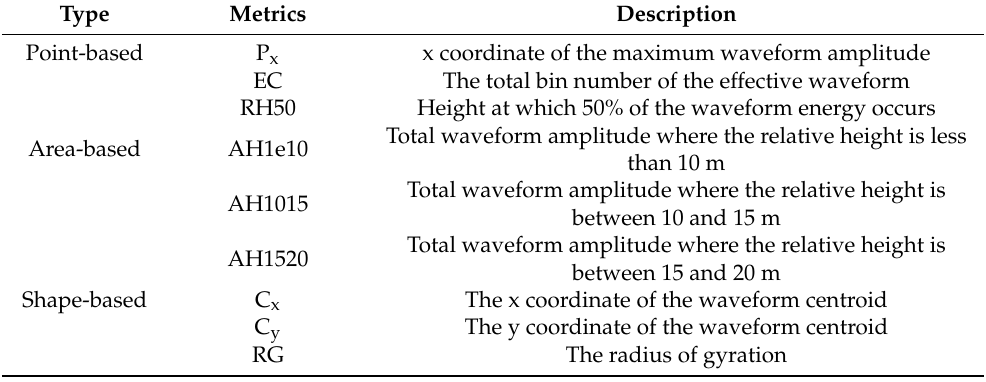
Table 2. LiDAR metrics are used to characterize a waveform as a function of the successional stage (after Gu et al.